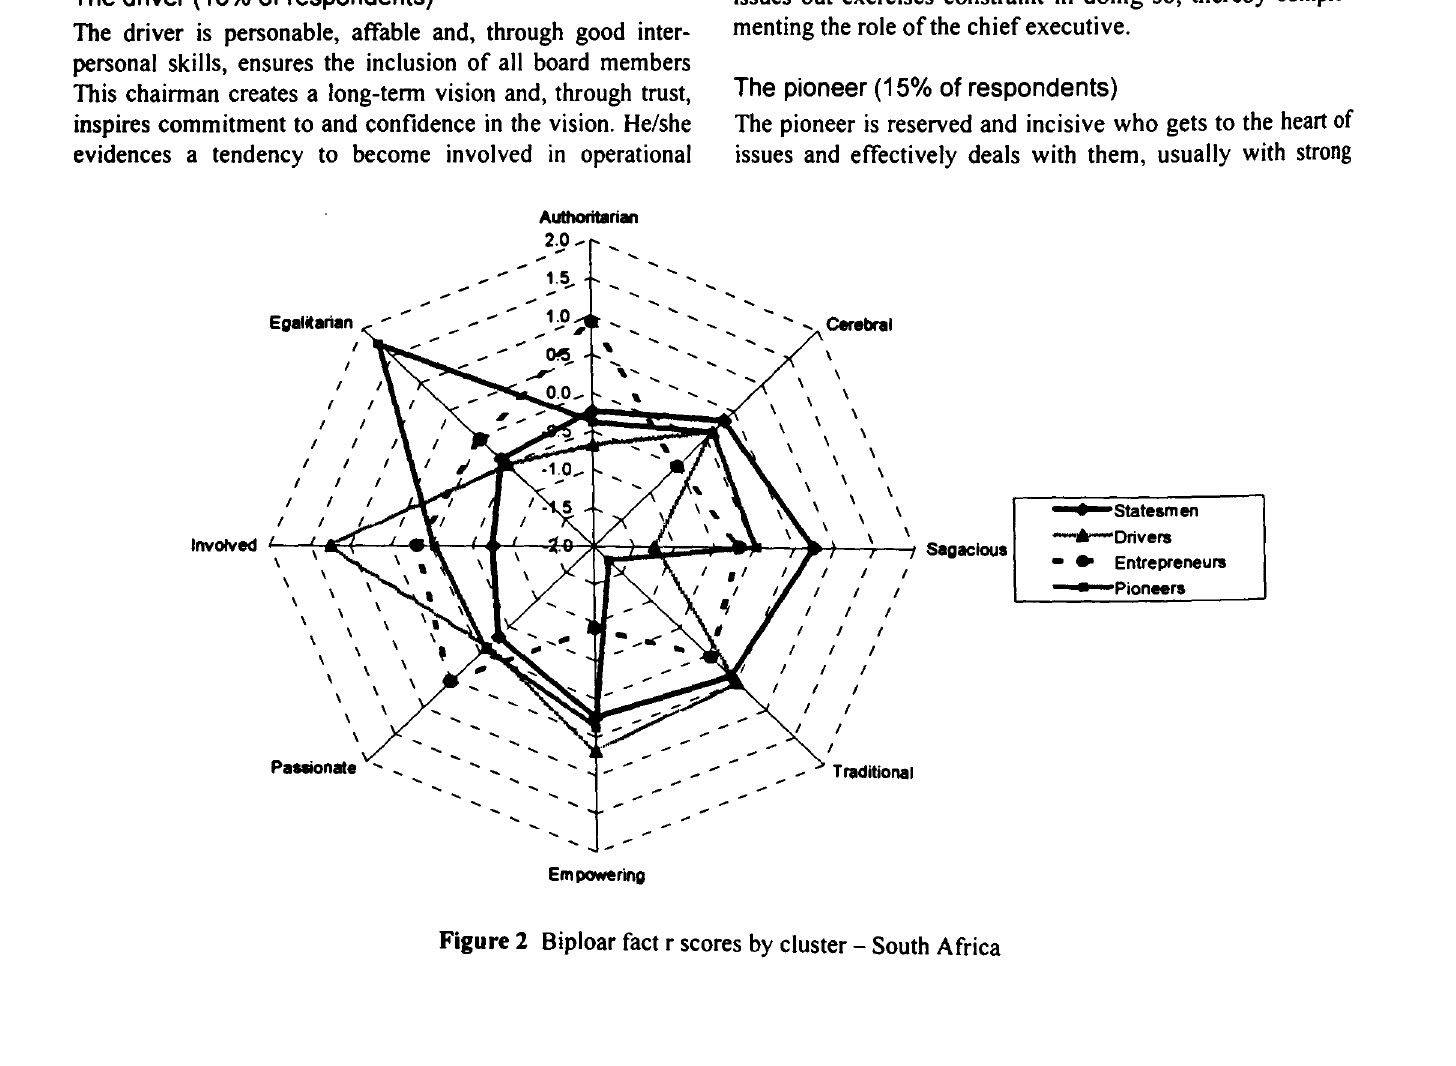
Figure I Bipolar factor scores by cluster - UK